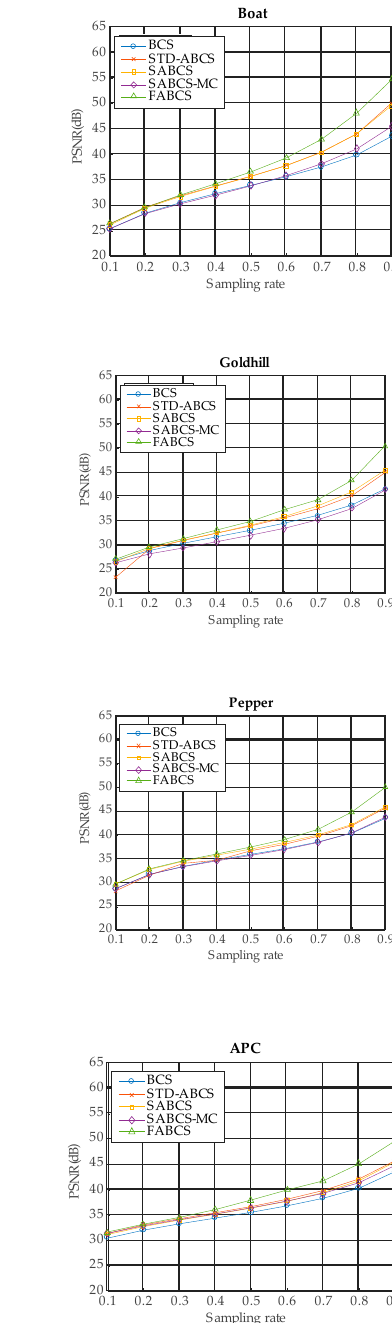
Figure 12. The experimental results for a block size of 32 × 32.